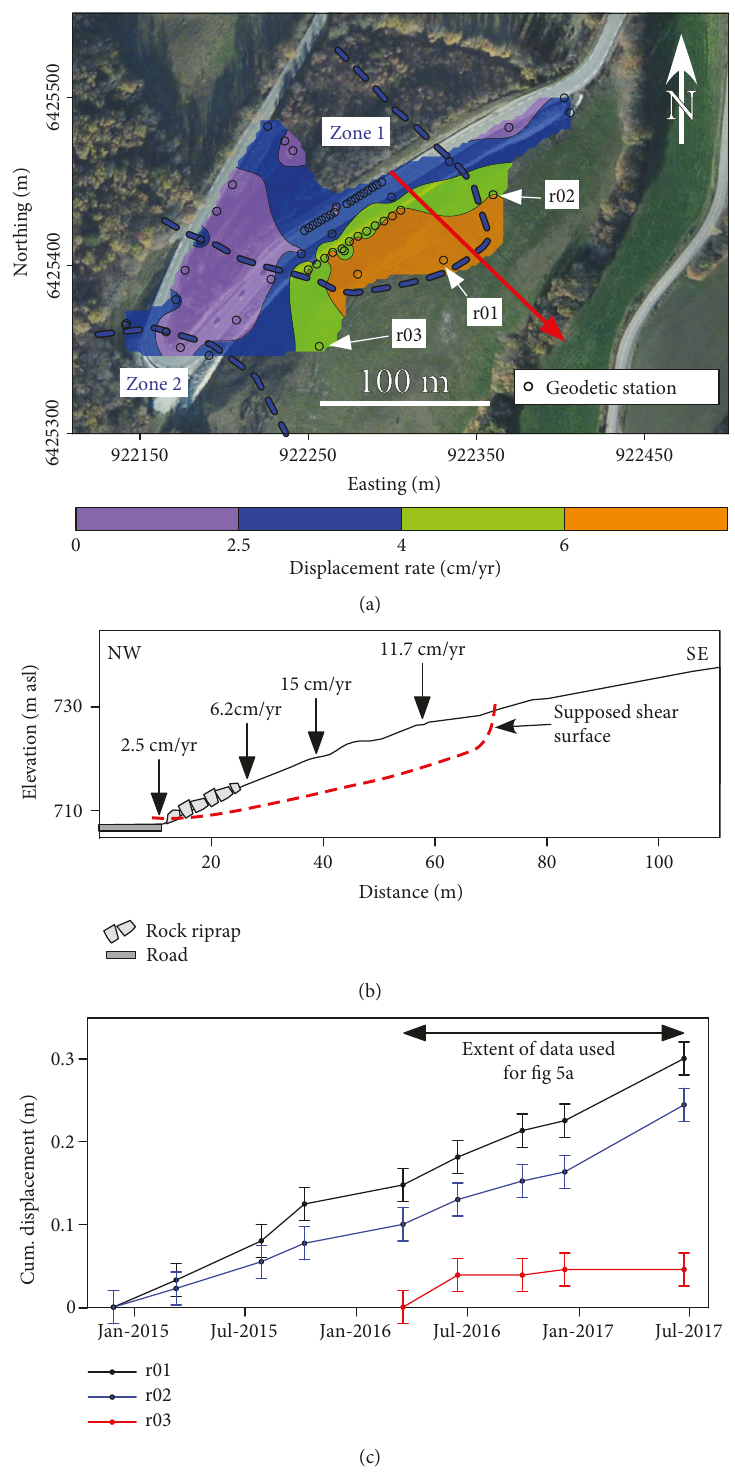
Figure 5: Surface deformation. (a) Interpolated map of surface displacement rates between March 2016 and June 2017. The red arrow corresponds to the topographic pro fi le in Figure 5(b). (b) Topographic cross section, surface displacement rates measured at geodetic stations, and supposed location of the shear surface at around 10 m depth. (c) Time series of cumulated total displacements (XYZ) for stations r01 and r02 between late November 2014 and late June 2017 and for station r03 between mid-March 2016 and late June 2017 (location in Figure